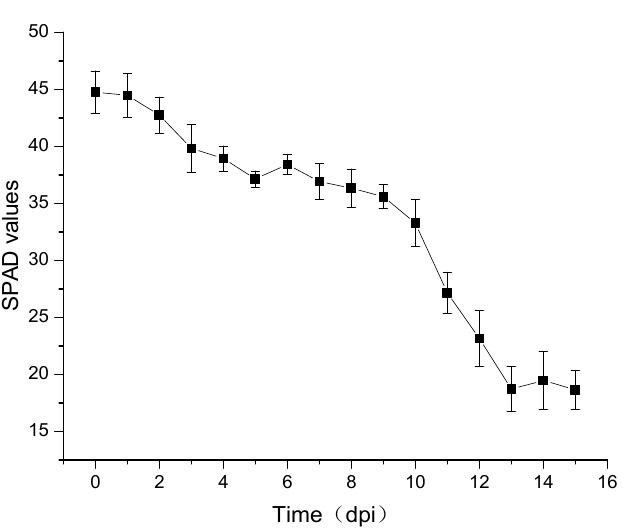
Figure 4. The average SPAD curve of wheat leaves during different days post-inoculation.